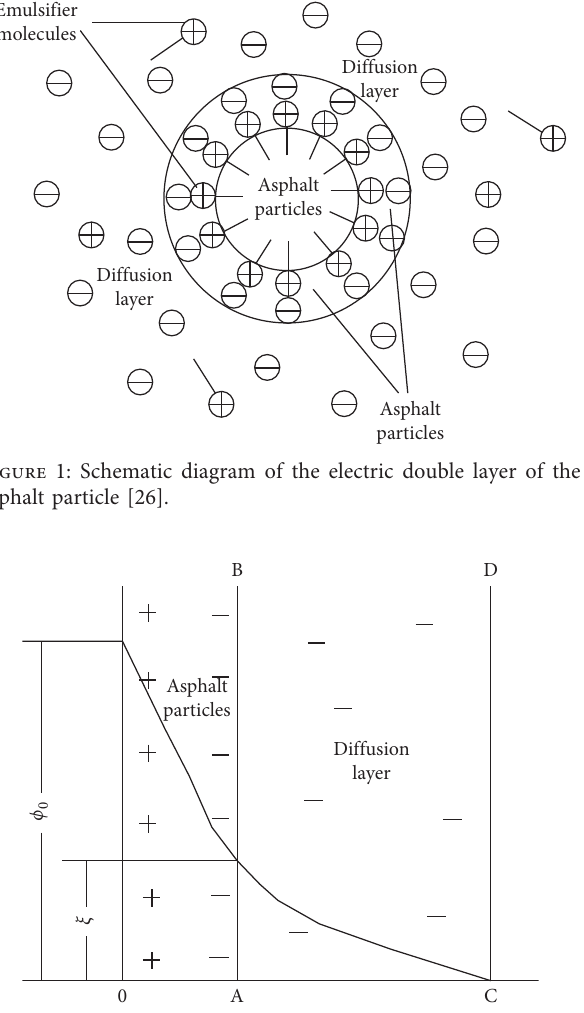
Figure 2: Schematic diagram of emulsified asphalt zeta potential